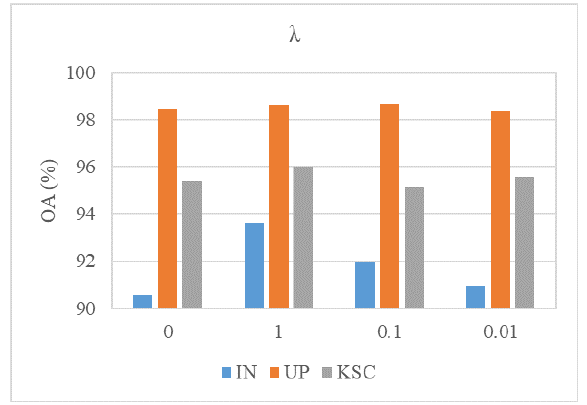
Figure 10. The overall accuracy of CFF-FCN with different λ